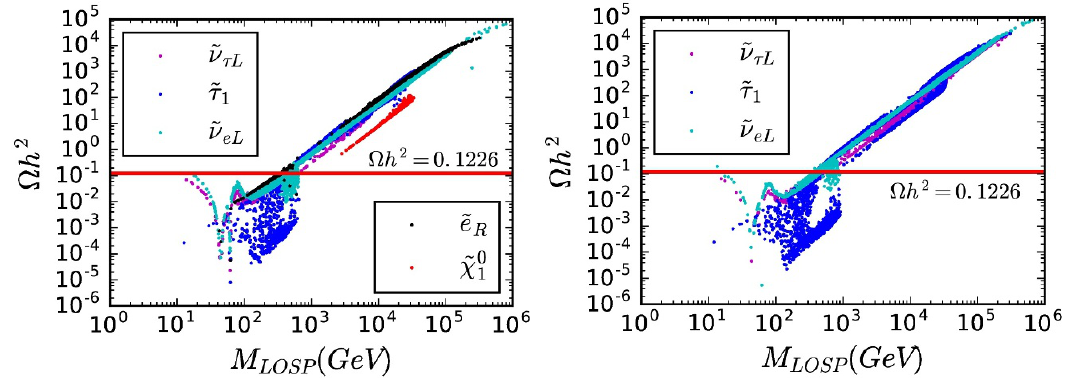
Figure 3 . The relic abundances of various LOSP particles for a = 3 (left panel) and a = 2 (right panel) in scenario